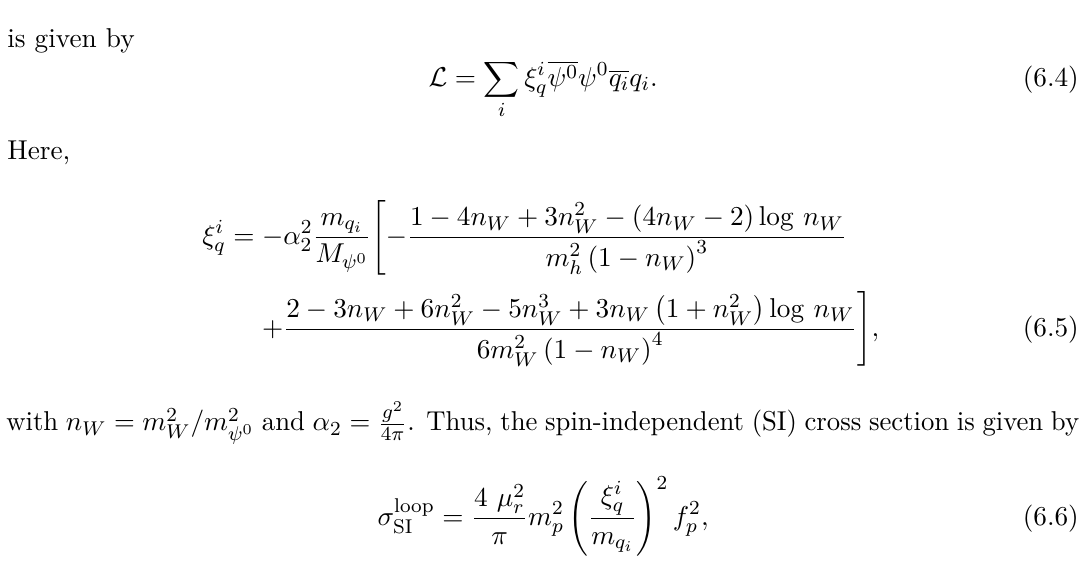
Figure 8 . Relic abundance as a function of DM mass with contributions from annihilation’s and co-annihilation’s of ψ 0 and ψ . Black horizontal dashed lines correspond to 3 σ region of Planck ± satellite